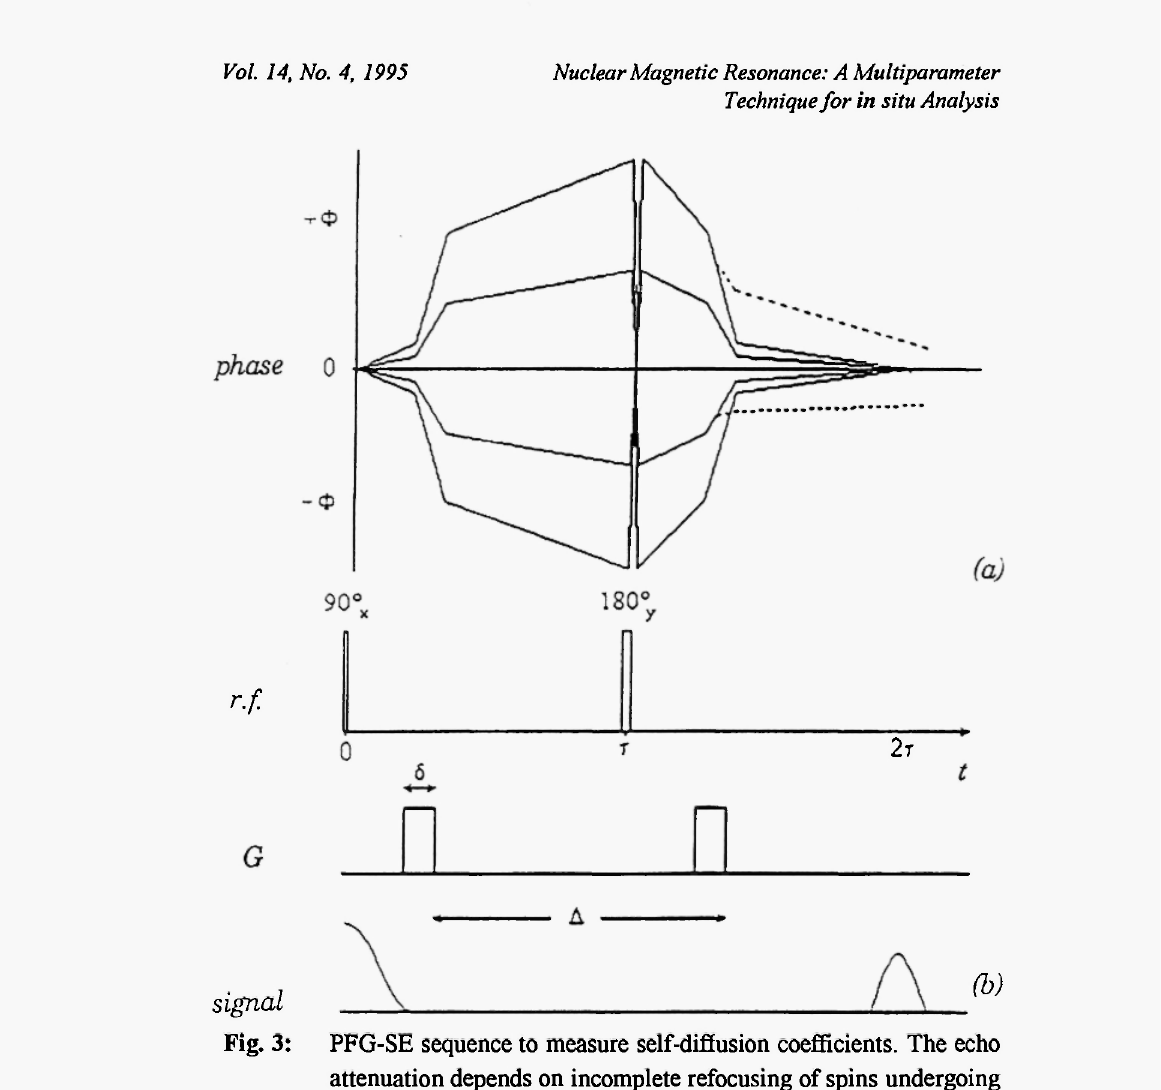
Fig. 3: PFG-SE sequence to measure self-diffusion coefficients. The echo attenuation depends on incomplete refocusing of spins undergoing incoherent